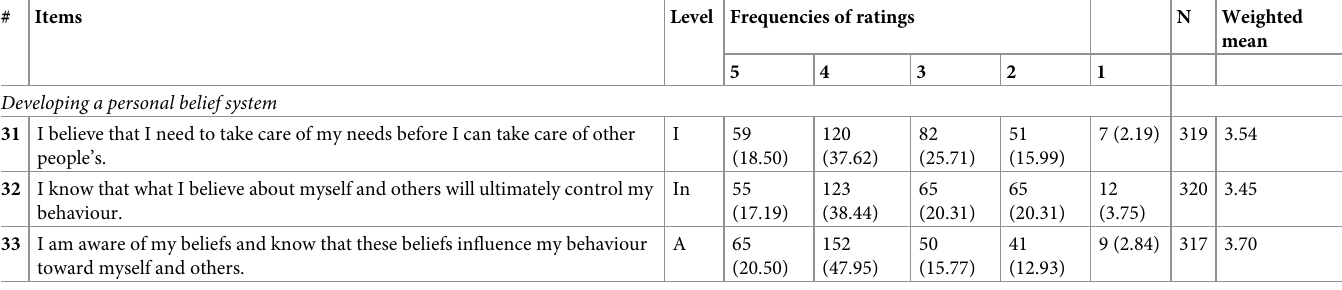
Table 4. Descriptive statistics for math teachers’ views about the influence of belief about self and self-efficacy. # Items